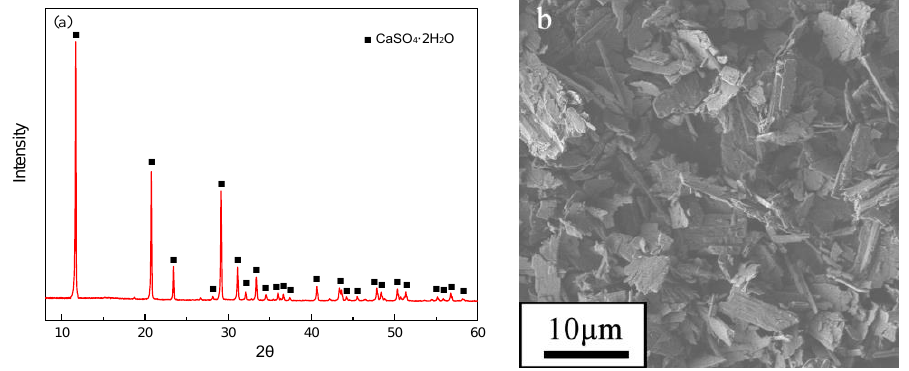
Figure 1. ( a ) XRD pattern and ( b ) SEM image of CaSO 4 ·2H 2 O after calcination and hydration treatment.